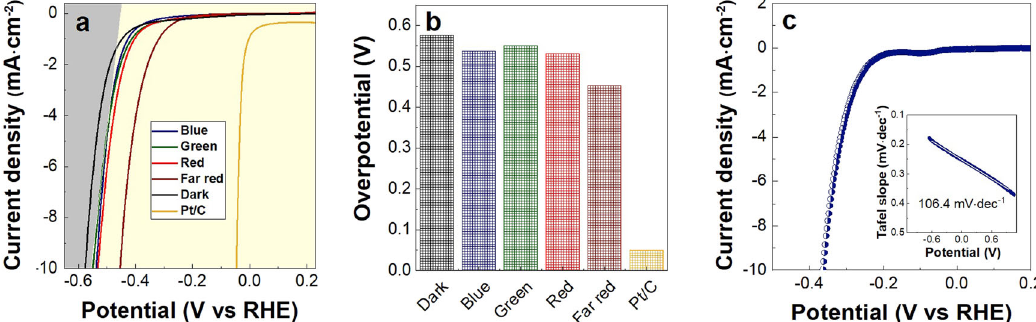
Fig. 7 Catalytic performance of a few-layer TaS 2 in HER. HER analysis in the medium of 0.5 M H 2 SO 4 at the scan rate of 1 mV·s − 1 in dark mode and during the blue, green, red, and far-red illumination. Polarization curves ( a ) and corresponding overpotentials ( b ) of exfoliated TaS 2 at a − 10 mA·cm − 2 current density; the measurements were conducted vs. RHE and compared with commercial Pt/C electrocatalyst. The gray and purple areas on the graph ( a ) correspond to the position of the polarization curves during the measurement in dark and illumination modes. Polarization curve and inserted corresponding Tafel plot ( c ) of few-layer TaS 2 small fl akes obtained after centrifugation; overpotential is 360